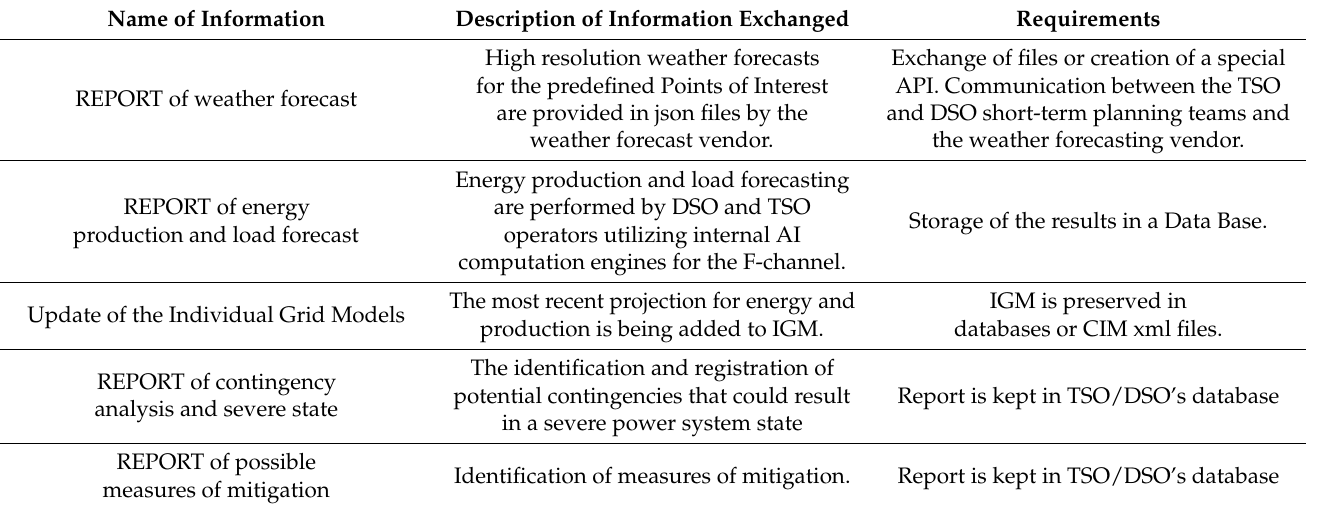
Table 6. Information exchange for the